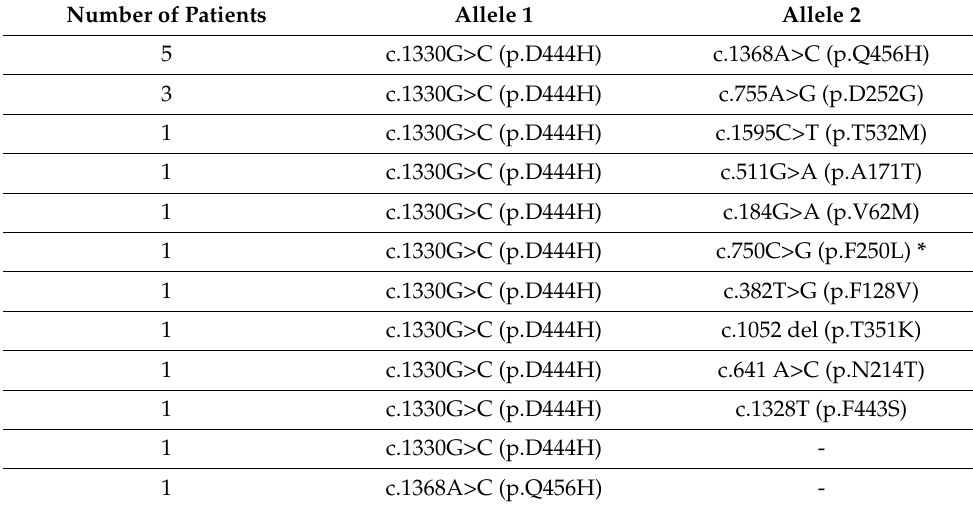
Table 1. BTD gene analysis of the infants with positive newborn screening test. Number of